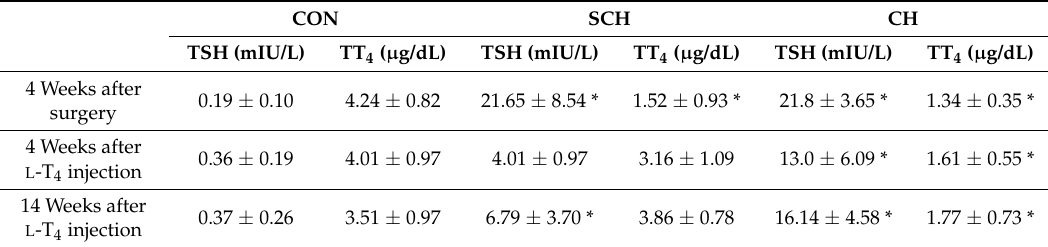
Table 1. Plasma levels of TT4 and TSH in each